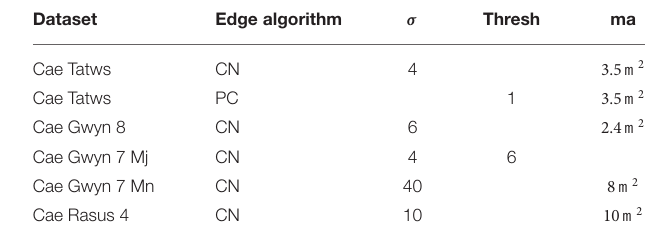
Frontiers in Plant Science |